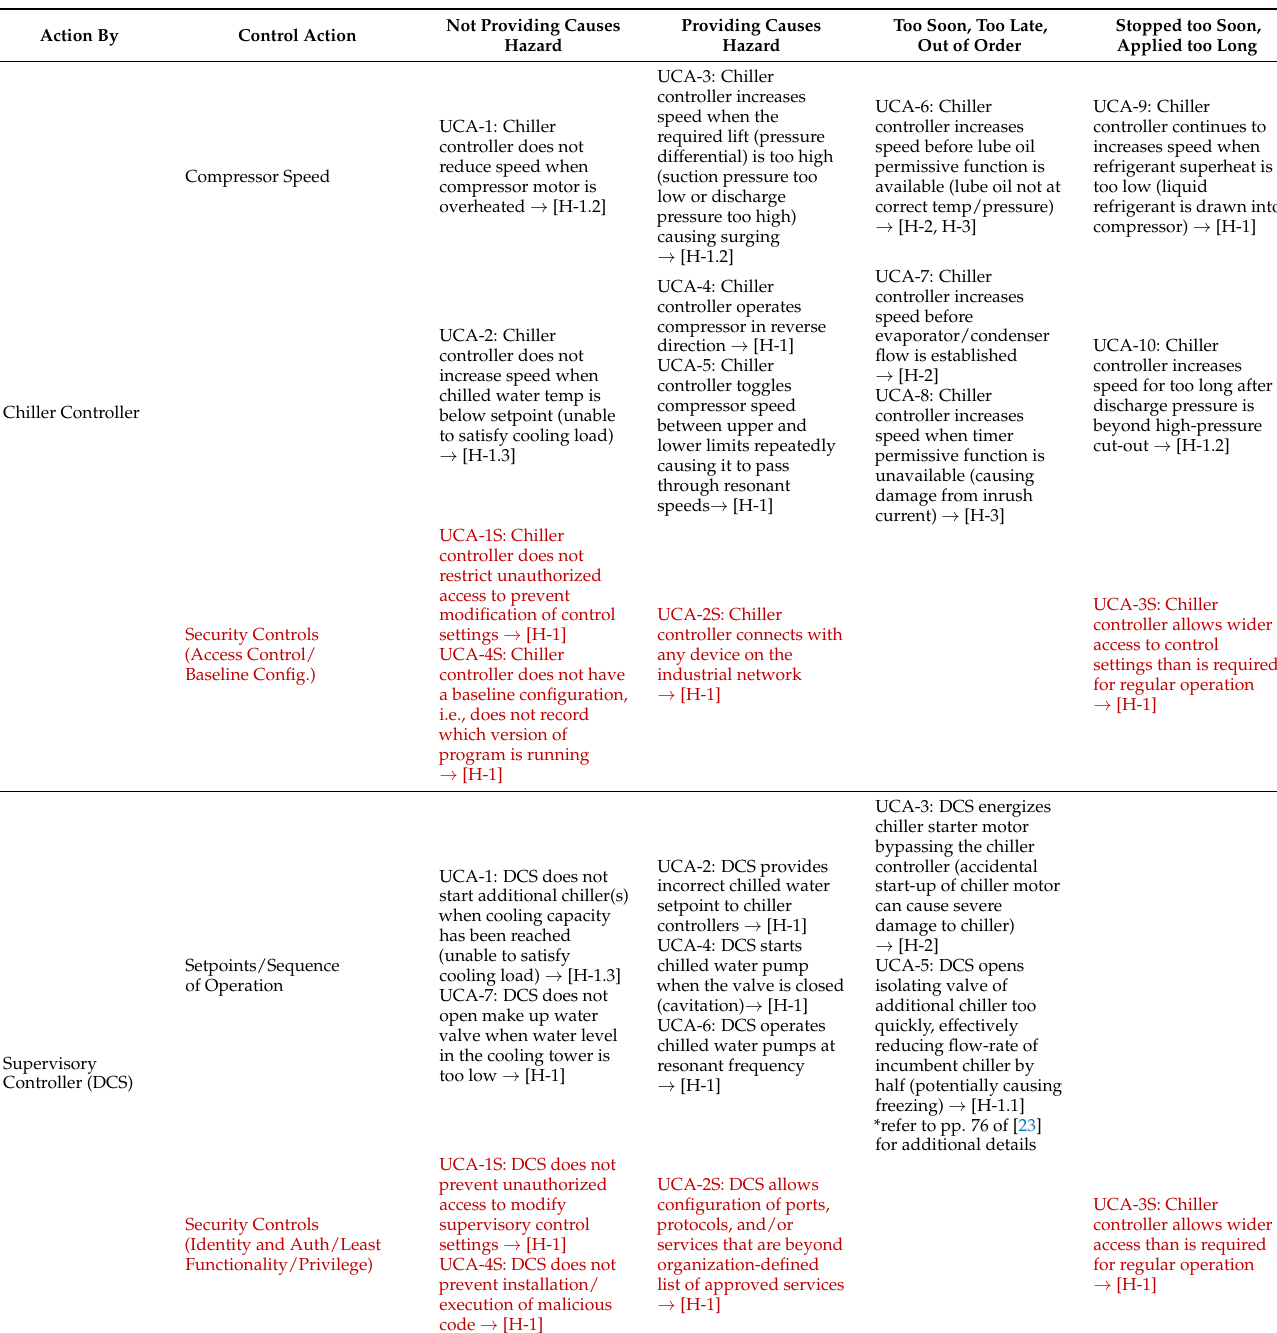
Table 3. Partial List of Unsafe and Insecure Control Actions for some controllers (Insecure Control Actions are listed in